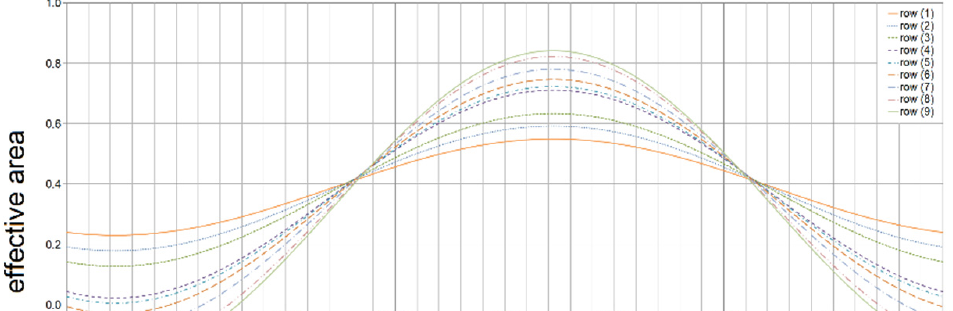
Figure 9. Effective area for ψ = 135°.